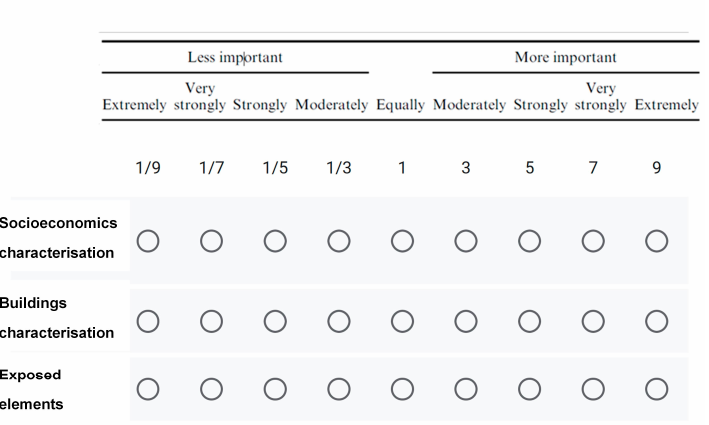
Figure 4. Example of a Google forms second level question (translated from the original questionnaire in Portuguese).